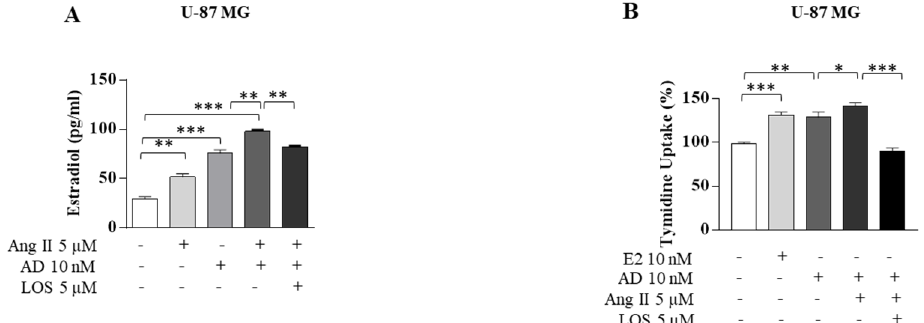
Figure 8. Ang II potentiates the estradiol levels produced by an aromatizable steroid androst-4-ene-3,17-dione in U-87 MG glioblastoma cells. ( A ) ELISA for Estradiol secretion treated with vehicle ( − ), Ang II 5 µ M, androst-4-ene-3,17-dione (AD 10 nM), Ang II 5 µ M plus AD 10 nM, and Ang II 5 µ M plus AD 10 nM plus LOS 5 µ M for 24 h. ( B ) Cell proliferation was determined by the [3H] thymidine assay in U-87 MG cells treated with vehicle ( − ), estradiol (E2 10 nM), Ang II 5 µ M, AD 10 nM, Ang II 5 µ M plus AD 10 nM, and Ang II 5 µ M plus AD 10 nM plus LOS 5 µ M for 24 h. Data are expressed as means ± SD of three different experiments, each performed in triplicate. * p < 0.05; ** p < 0.01; *** p < 0.001.